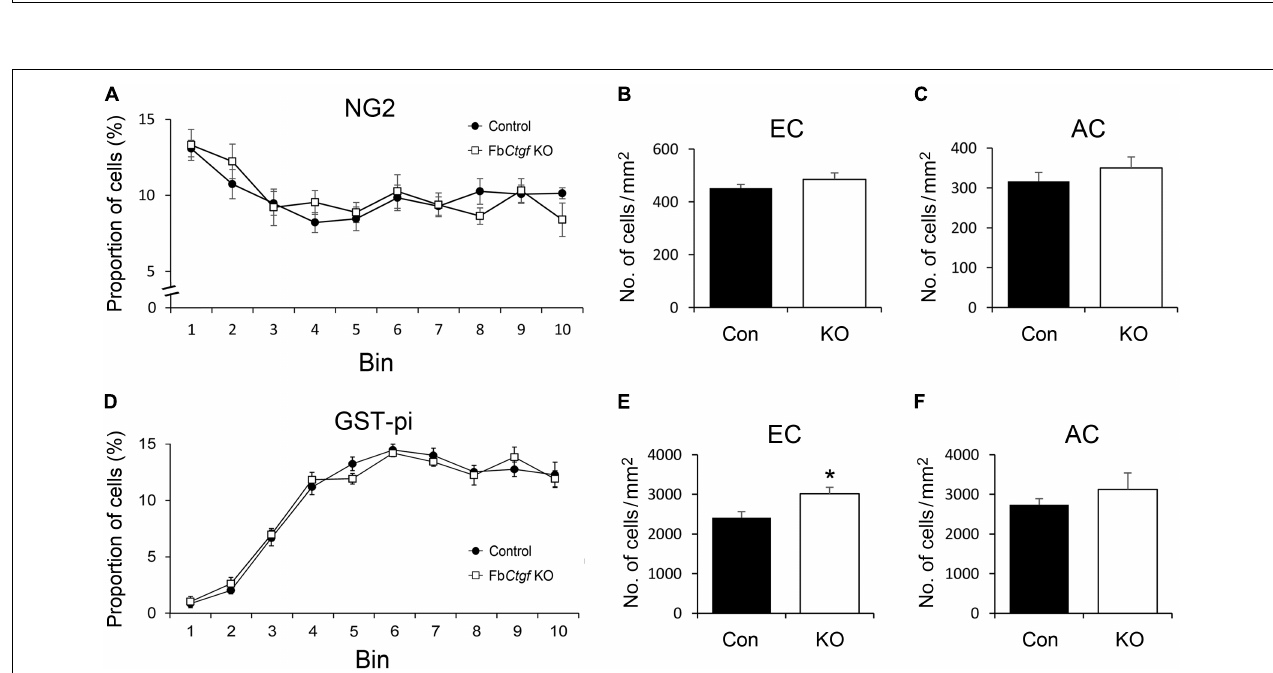
FIGURE 7 | Distribution of oligodendrocytes in the brain. In the somatosensory cortex, higher proportions of NG2-positive oligodendrocytes were distributed in the upper layers of the cortex relative to the middle and lower regions in both control and Fb Ctgf KO mice (A) . The densities of NG2-positive oligodendrocytes were similar between genotypes in both EC (B) and AC (C) . Notably, fewer GST-pi-positive oligodendrocytes were counted in the upper layers of the somatosensory cortex in both control and Fb Ctgf KO mice (D) . In the EC, the density of GST-pi-positive oligodendrocytes was higher in Fb Ctgf KO mice than in control mice (E) . In the AC, the densities of GST-pi-positive oligodendrocytes were comparable between genotypes (F) n = 5 in each genotype. Results are means ± SEM ( ∗ p < 0.05).